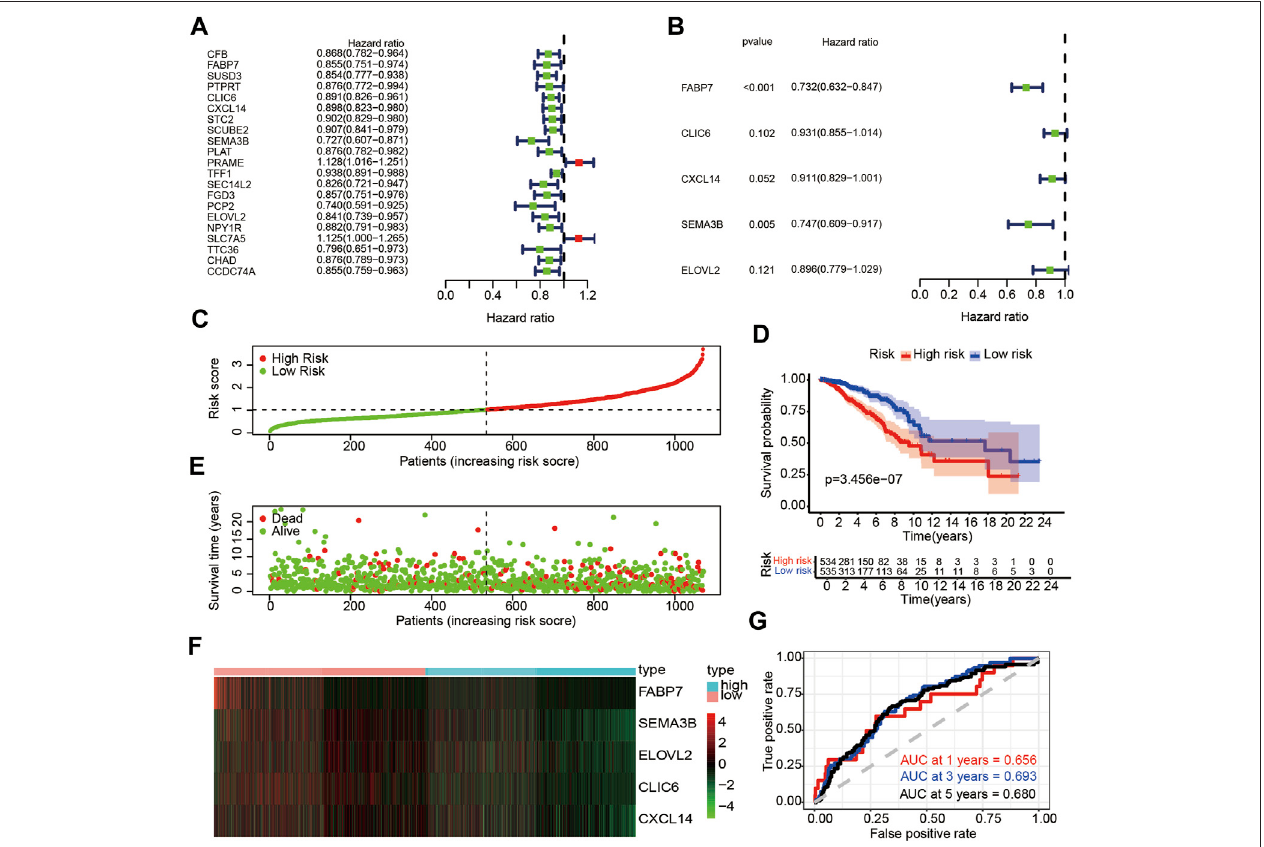
FIGURE5| Identi fi cationofDE-IRGswithprognosticvalueinbreastcancer (A) UnivariateCoxregressionanalysisofDE-ARGsandimmunegenes. (B) Multivariate Cox regression of DE-IRGs based on univariate Cox regression analysis (C) The risk score strati fi ed the breast cancer patients into high-risk groups ( “ High ” red line) and low-risk groups ( “ Low ” green line) in training set (D) Kaplan-Meier survival curves compared survival probability between the high-risk groups and low-risk group in trainingset. (E) Survivaltimeandsurvivalstatusofpatientsinbreastcancercomparedbetweenhigh-riskgroupsandlow-riskgroupsintrainingset.Greenplotsfor alive, red plotsfor dead (F) Heatmap indicated expression ofthe fi ve DE-IRGs inbreast cancer. Blue color represents high group, whilepink color represents lowgroup. (G) Time-dependent ROC curves for DE-IRGs model to predict patient survival in training set.